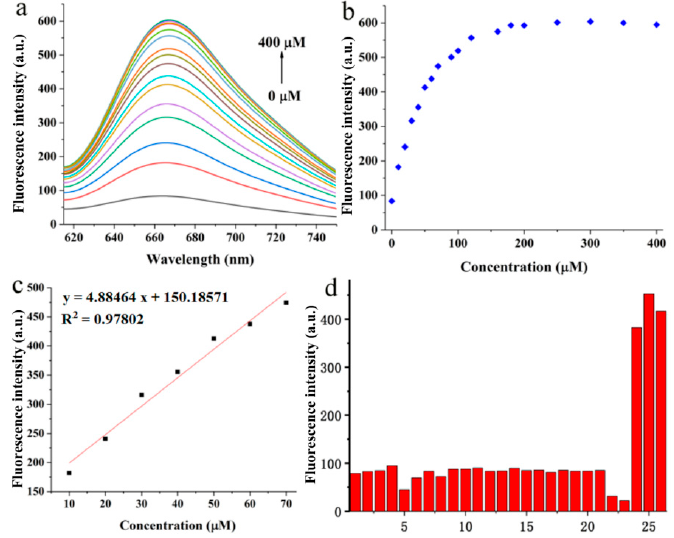
Figure 3. ( a ) Fluorescence responses of BPO-DNSP to GSH and ( b ) fluorescence responses of BPO- DNSP (10 μ M) to different concentrations of GSH (0–400 μ M); ( c ) plot of BPO-DNSP fluorescence BPO-DNSP (10 µ M) to different concentrations of GSH (0–400 µ M); ( c ) plot of BPO-DNSP